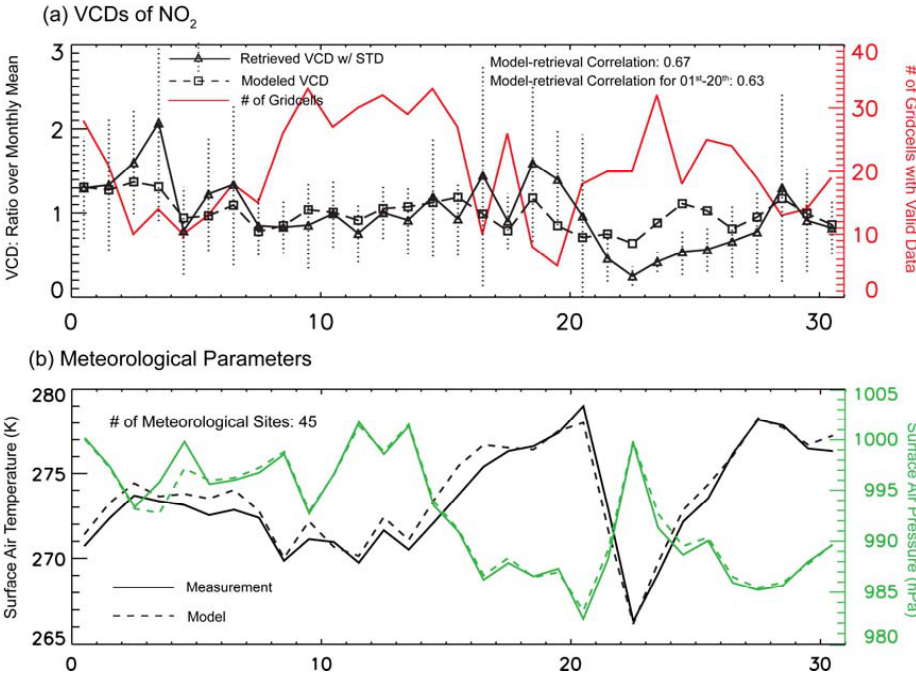
Fig. 10. Daily variations of regional mean VCDs of NO 2 and meteorological parameters in January 2009. (a) Variations of retrieved (OMI KNMI) and modeled VCDs of NO 2 relative to regional means. Data in a given day are derived as the mean of the ratios of VCDs in gridcells with valid retrievals in that day over monthly mean VCDs in corresponding gridcells. Also shown is the number of gridcells out of the total of 36 over the region in each day that contain valid retrieval data. (b) Variations of measured and modeled daily average surface air temperature and surface air pressure. Meteorological measurements are taken from the global hourly dataset (DS3505) archived in the National Oceanic and Atmospheric Administration (NOAA) National Climatic Data Center (NCDC) (http://www7.ncdc.noaa.gov/CDO/cdo; see Lin et al. (2010a)). Daily average values for air temperature (air pressure) are calculated to be means over 3-hourly (6-hourly) data in correspondence to the temporal resolutions of individual model